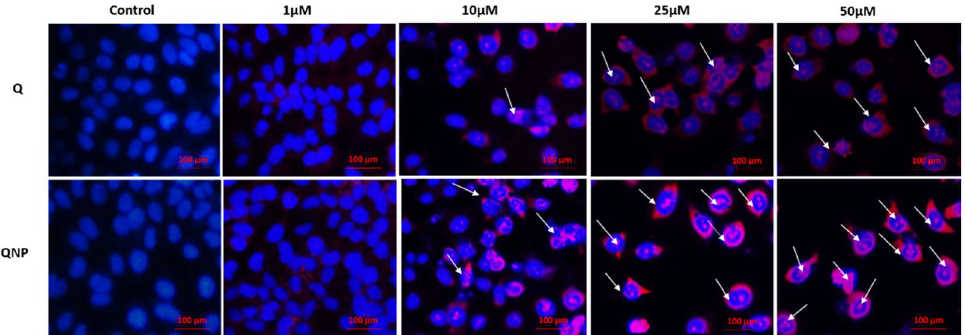
Figure 5. Fluorescence micrographs of Hoechst-PI double stained HeLa cell line treated with different concentrations of Q or QNPs for 48 h. Apoptotic cells are indicated by arrows.